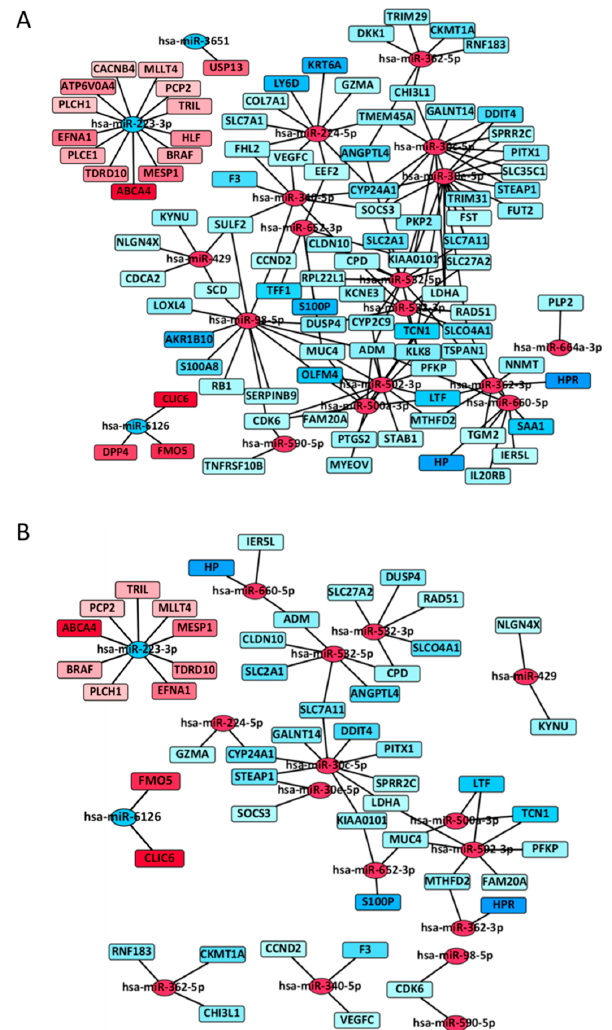
Figure 2. MiRNA–mRNA interactive network in EGFR -mutant lung adenocarcinoma. ( A ) Network of 149 miRNA-mRNA interactions in EGFR -mutated lung adenocarcinoma; ( B ) Network of 63 statistically significant miRNA–mRNA interactions in EGFR -mutated lung adenocarcinoma ( p < 0.01). Circles and squares represent miRNAs and mRNAs, respectively. Red indicates an upregulated miRNA or mRNA, whereas blue indicates a downregulated miRNA or mRNA. A line indicates an miRNA–mRNA interaction. The color intensity is proportional to the fold change (continuous) of EGFR -mutated/wild-type lung adenocarcinoma.